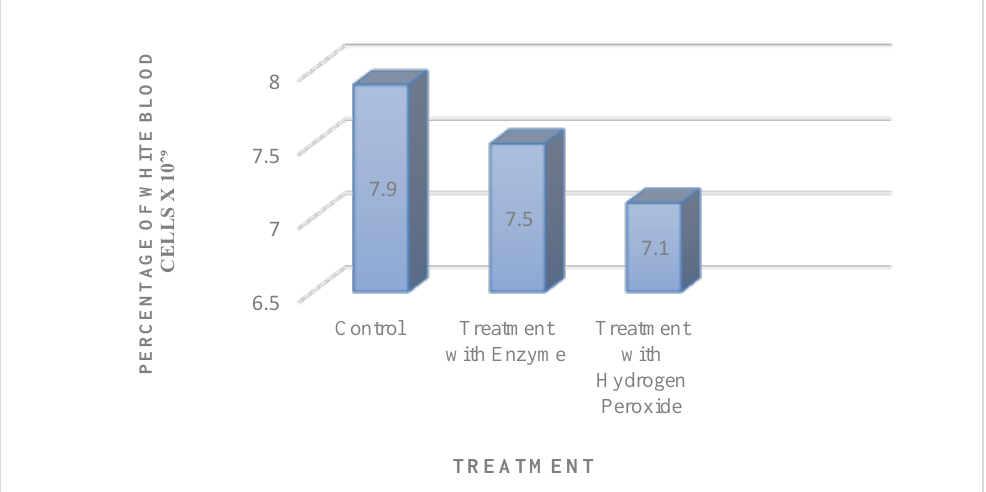
Figure 4. The effect of the studied treatments on the percentage of white blood cells. Note* Studied treatment means Control: Only human blood without any addition.